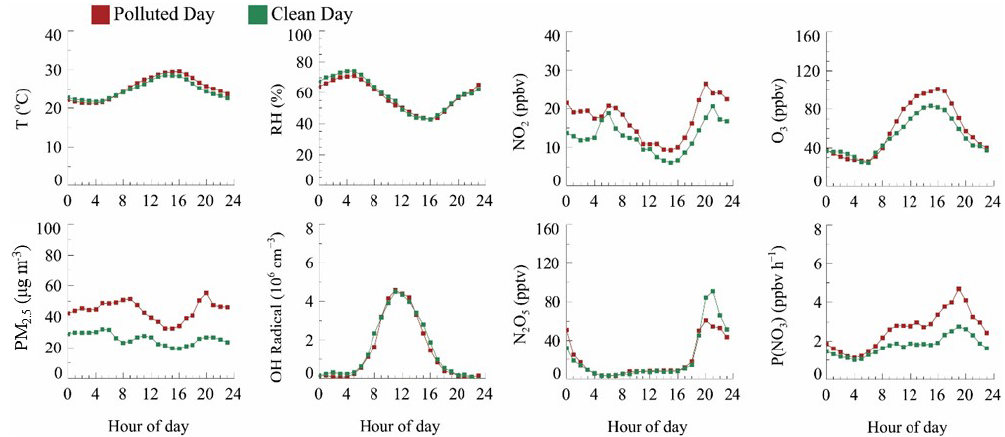
Figure 3. The mean diurnal variations of temperature, RH, NO 2 , O 3 , PM 2 . 5 , OH radicals (orange), N 2 O 5 , and P(NO 3 ) of clean days and polluted